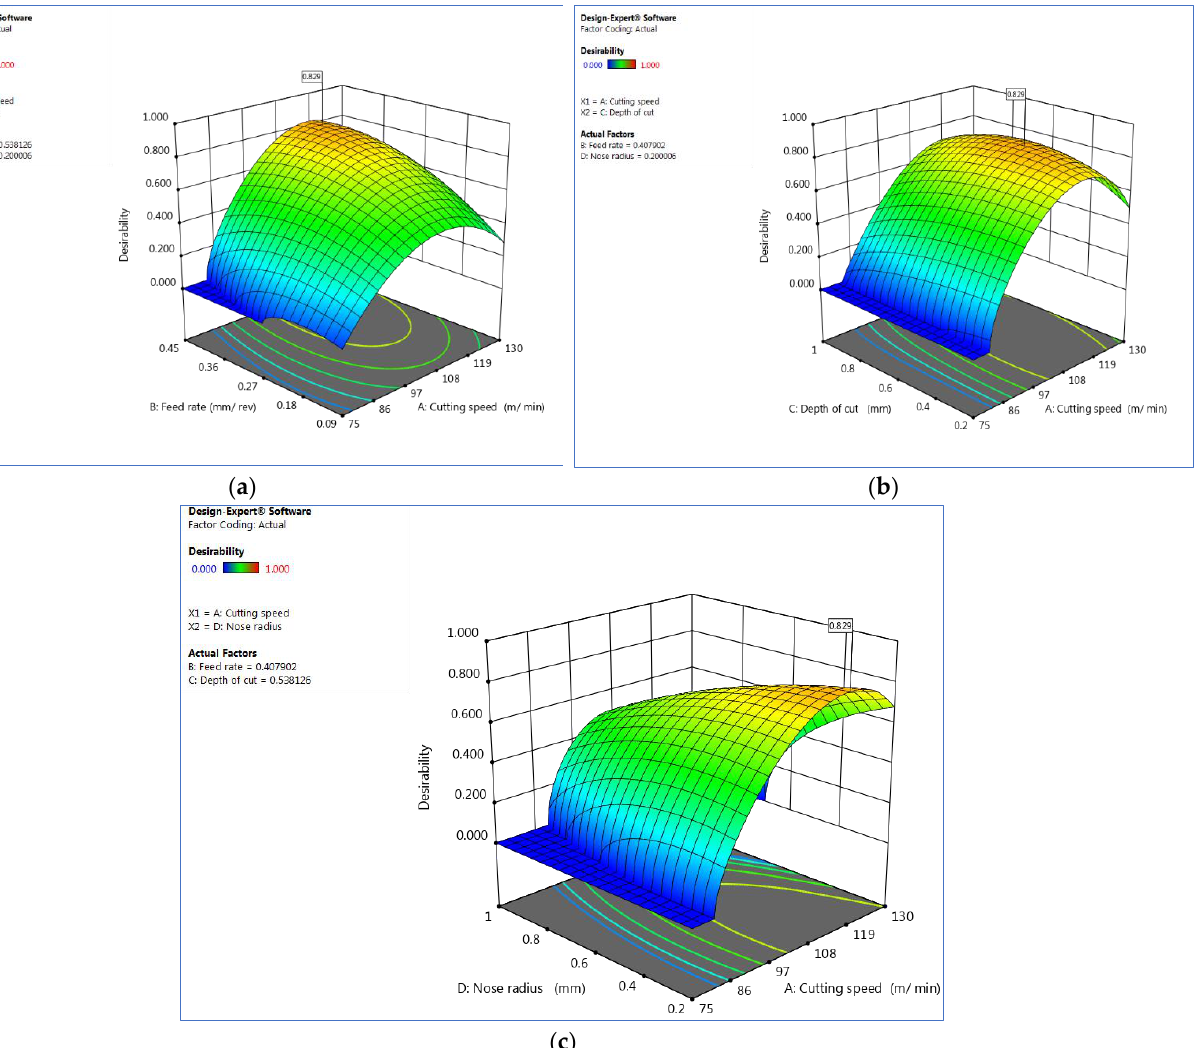
Figure 5. Estimated surface plots on desirability ( a ) V c vs. F z , ( b ) V c vs. D c and ( c ) V c vs. R n . Plots produced using Design-Expert software V11 (StatEase, Minneapolis, MN, USA).